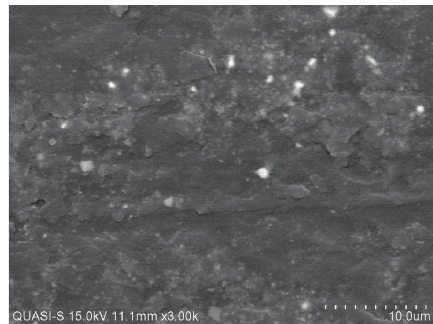
Figure 13: SEM micrograph of an unpolished surface after aging treatment.